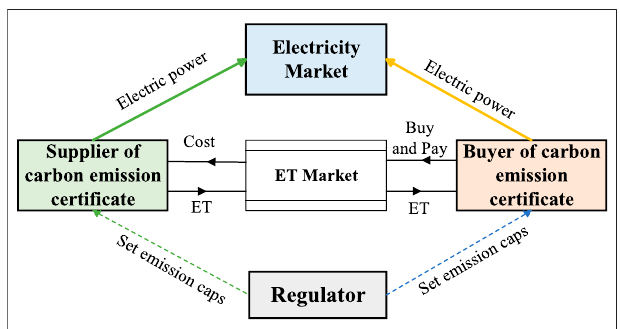
FIGURE 6 | Operation process of the carbon emissions emission